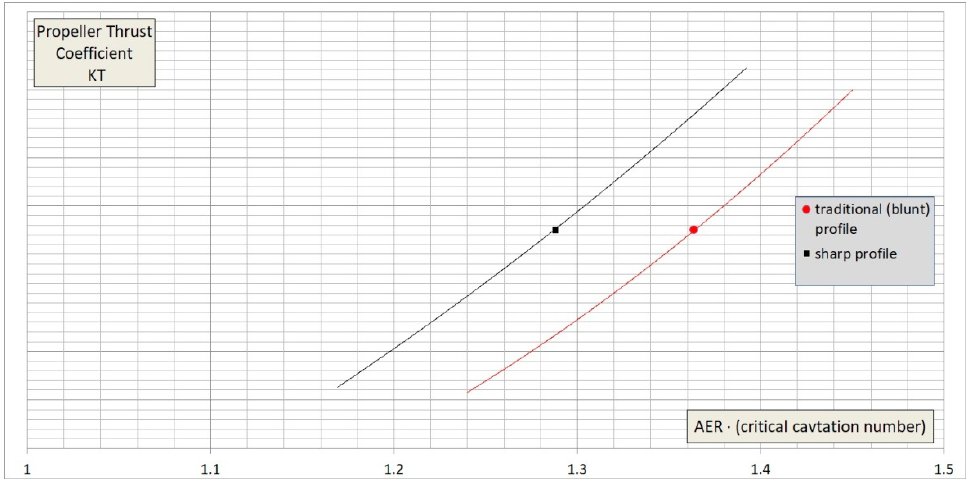
Figure 17. Cavitation diagrams (thrust breakdown point) of propellers with sharp and blunt pro-